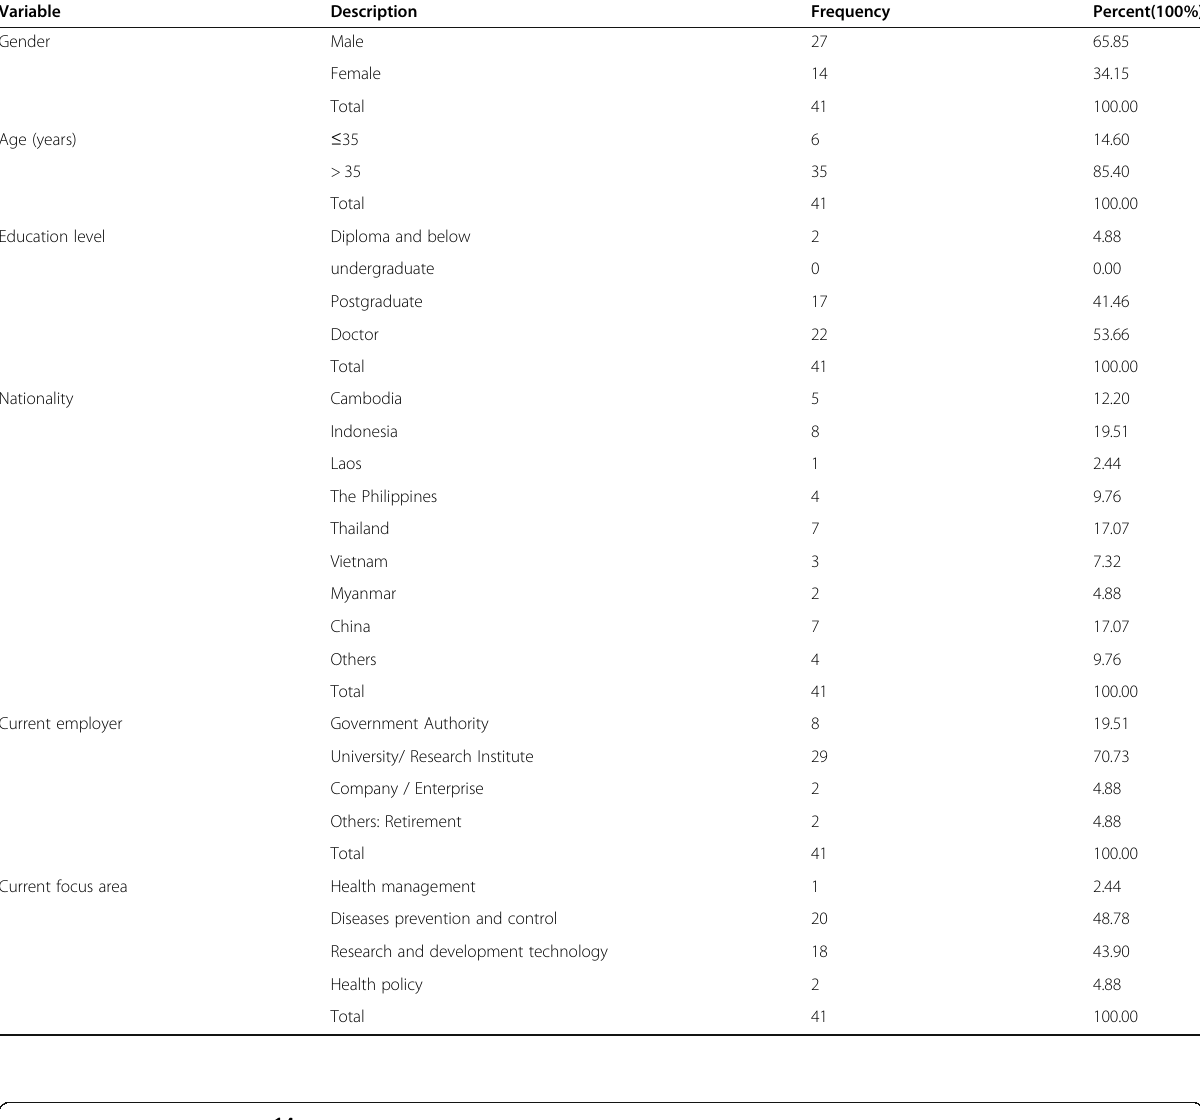
Table 2 Characteristics of the survey respondents